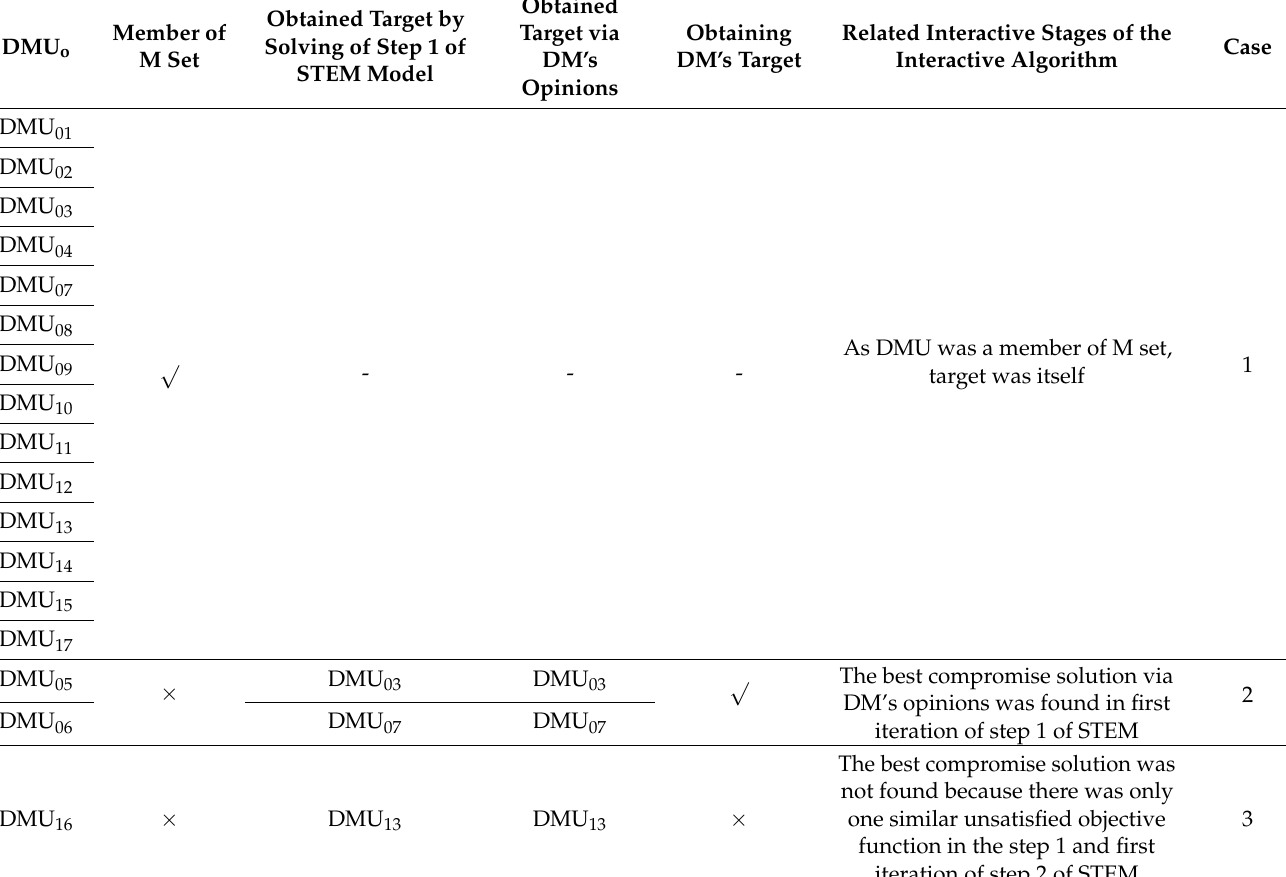
Table 8. The brief of applying the interactive algorithm for finding DMU targets (the first case study).